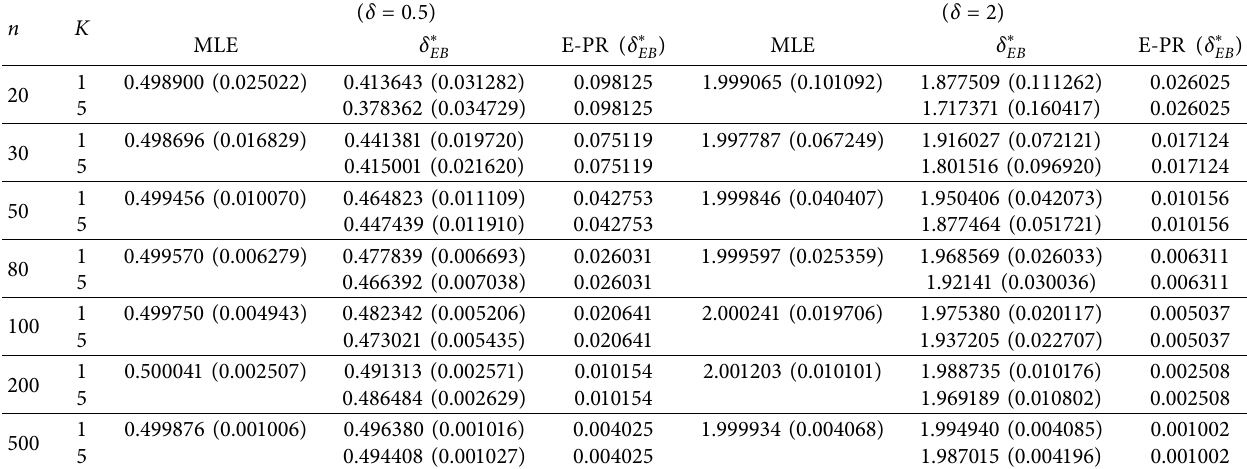
Table 4: E-B and E-PR estimates of